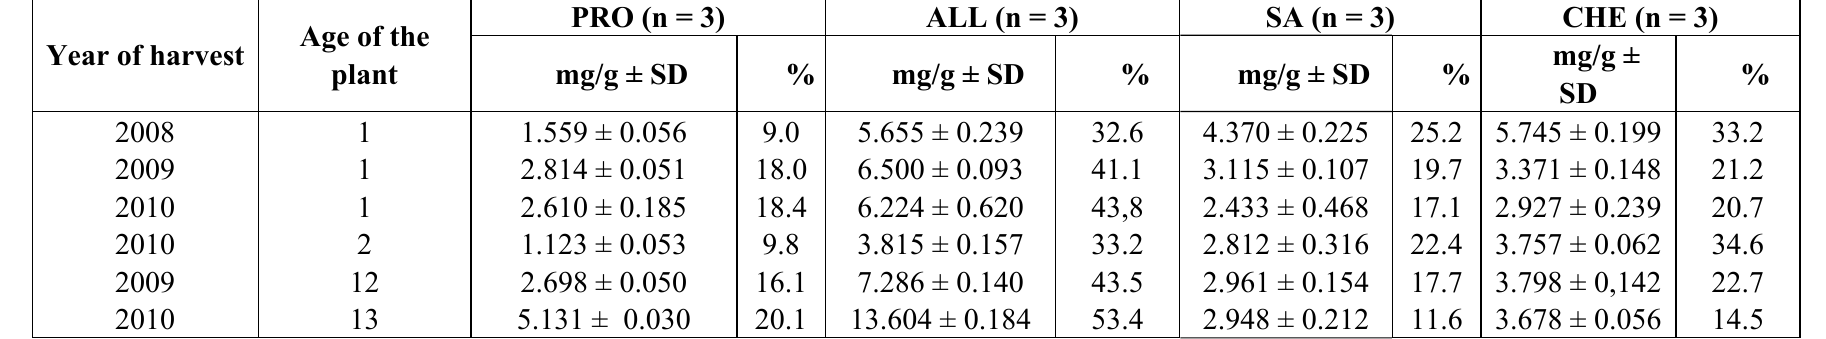
Table 1. Content of isoquinoline alkaloids from aerial part of M. microcarpa depending on the age of herb.